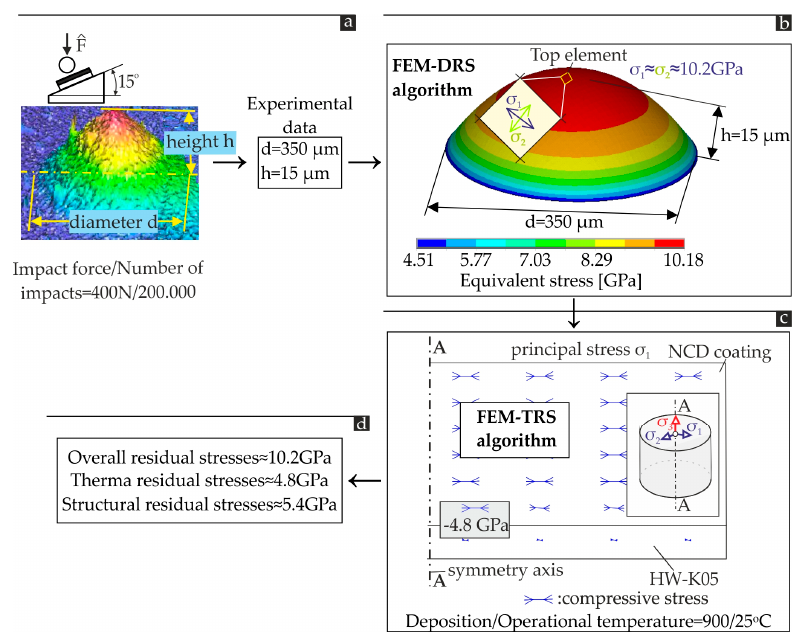
Figure 5. ( a ) Determination of the input parameters (diameter and height of the formed bugle) in the FEM-DRS algorithm; ( b ) calculation of the overall compressive stresses in the diamond film structure via FEM-DRS algorithm; ( c ) calculation of the thermal compressive stresses in the diamond film structure via FEM-TRS algorithm; ( d ) determination of the structural stresses in the diamond film structure.